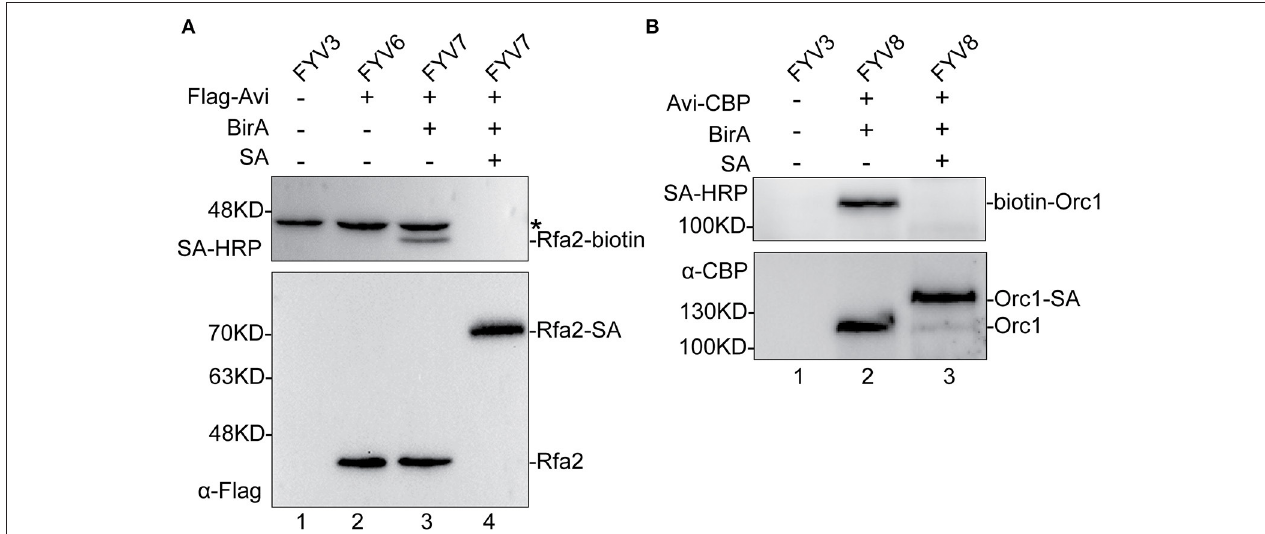
FIGURE 2 | Detection and evaluation of biotinylation of Rfa2 and Orc1 using Western blotting. Whole-protein extracts of yFYV3, yFYV6, yFYV7, and yFYV8 were used to analyze the biotinylation of target proteins. (A) Rfa2 biotinylation by BirA in vivo was successfully detected using streptavidin-HRP in lane 3 (top). The bands in lanes 1–3 (top), which are most likely Arc1, are indicated by an asterisk. Biotinylated Rfa2 (Rfa2-biotin) was almost totally shifted in the presence of streptavidin in lane 4, which was analyzed using streptavidin-HRP (top) and anti-Flag antibody (bottom). (B) Orc1 biotinylation. Biotinylated Orc1 (biotin-Orc1) was detected successfully in lane 2 (top), and 91% Orc1 was shifted in the presence of streptavidin (SA) in lane 3 (bottom), which was quantified using Image